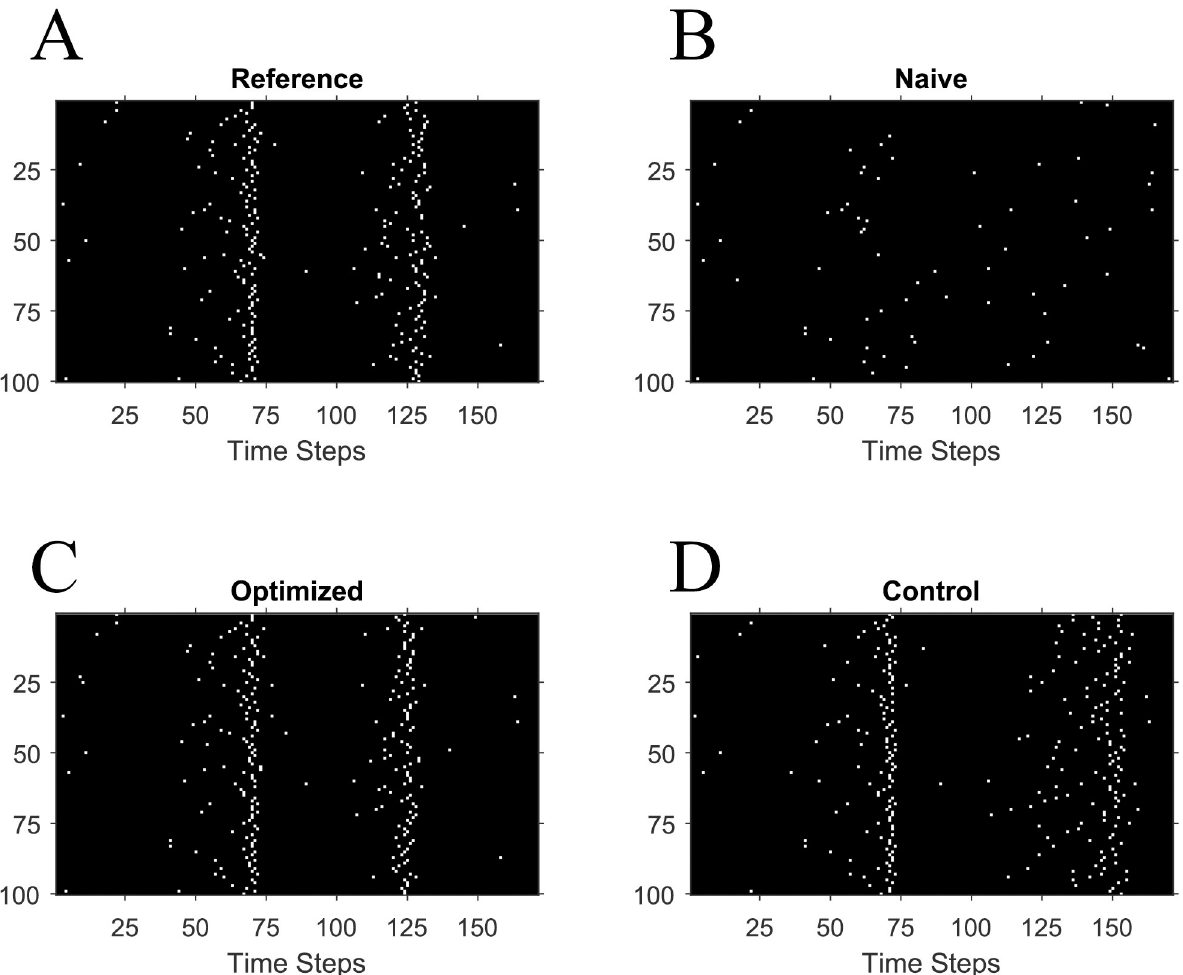
Fig 3. PSPM improves qualitative agreement in output spike trains. ( A ) The outputs R the reference network for a representative trial when stimulated with Gaussian input currents and initialized with the naive-half-max conditions. Neuron identity is plotted on the y-axis, while time is plotted on the x-axis. These spike trains serve as the goal output firing activity throughout the application of the algorithm. ( B ) The outputs N of a na ï ve network simulated with identical inputs as the reference network used in ( A ). Note that the dissimilarity in outputs between ( A ) and ( B ) is due entirely to differences in the weight matrices of the reference and naive networks. ( C ) After optimization of the weight matrix, the network’s firing activity O is qualitatively similar to that of the reference network. ( D ) The spiking C of the control network also differs from the reference. The weights of the control network are changed each time the algorithm would have made a change to a specific weight in the optimized network, but at a different random synapse instead. Thus, the disparity in performance between the optimized and control networks is due to PSPM’s neuron-by- neuron precise weight